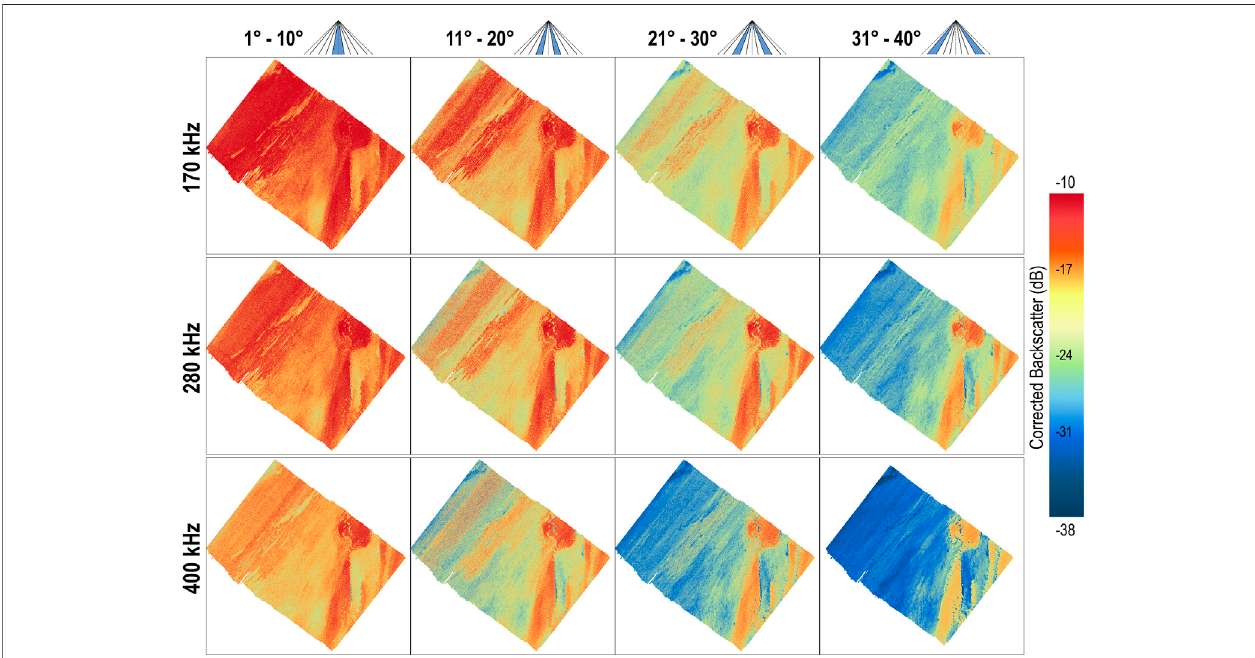
FIGURE 11 | Angular range analysis results obtained by extraction of backscatter values for each 10 ° angular sector.